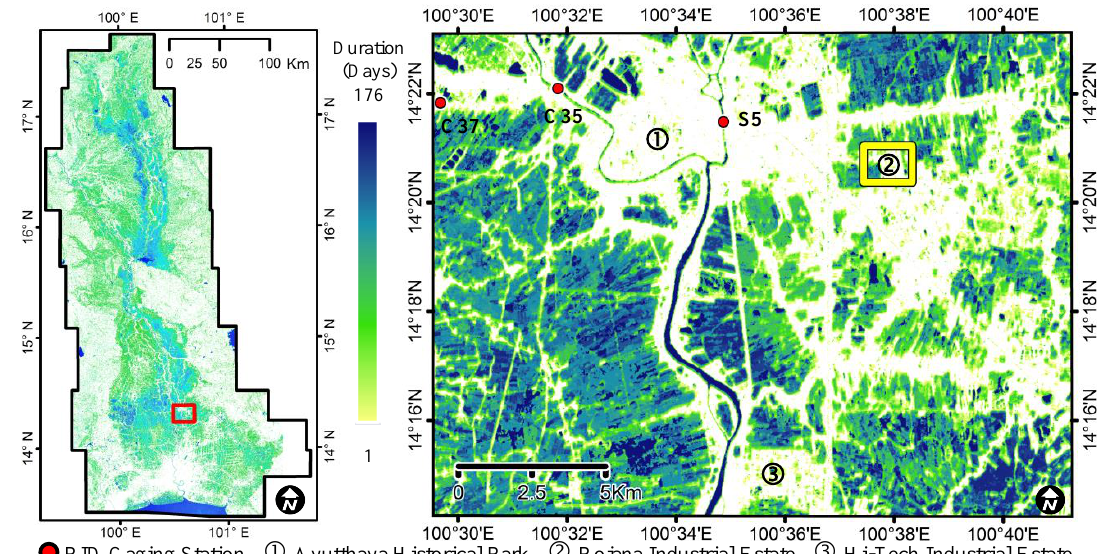
Figure 7. Water duration map calculated by stacking the extracted water surfaces. The red border shows Ayutthaya City, an enlargement of which is shown on the right side of the figure. The yellow border shows the Rojana industrial park.